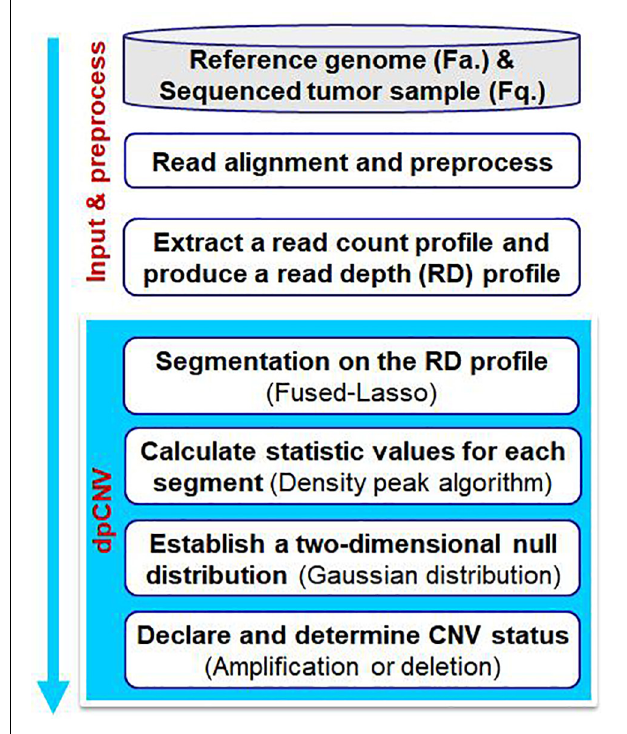
FIGURE 1 | Workflow of the dpCNV method to detect copy number variations from tumor samples with next-generation sequencing